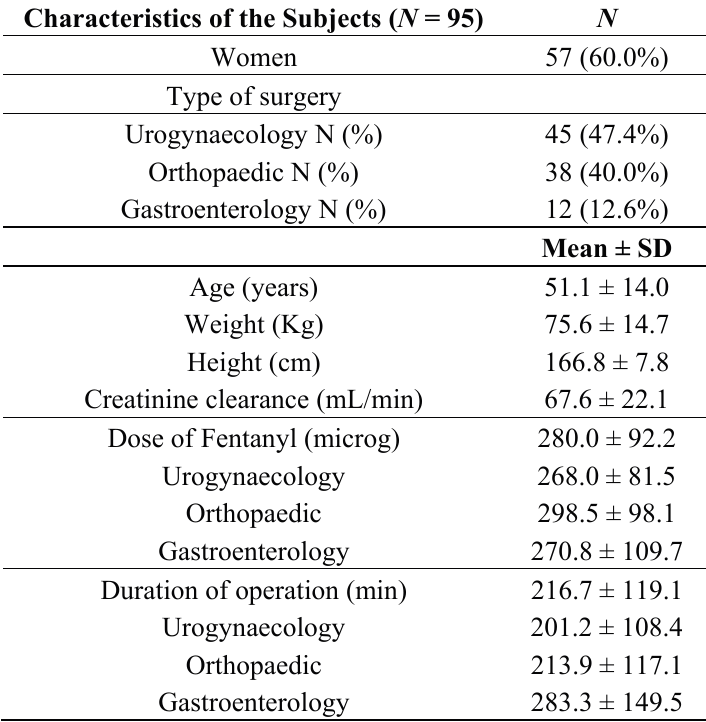
Table 1. Characteristics of the